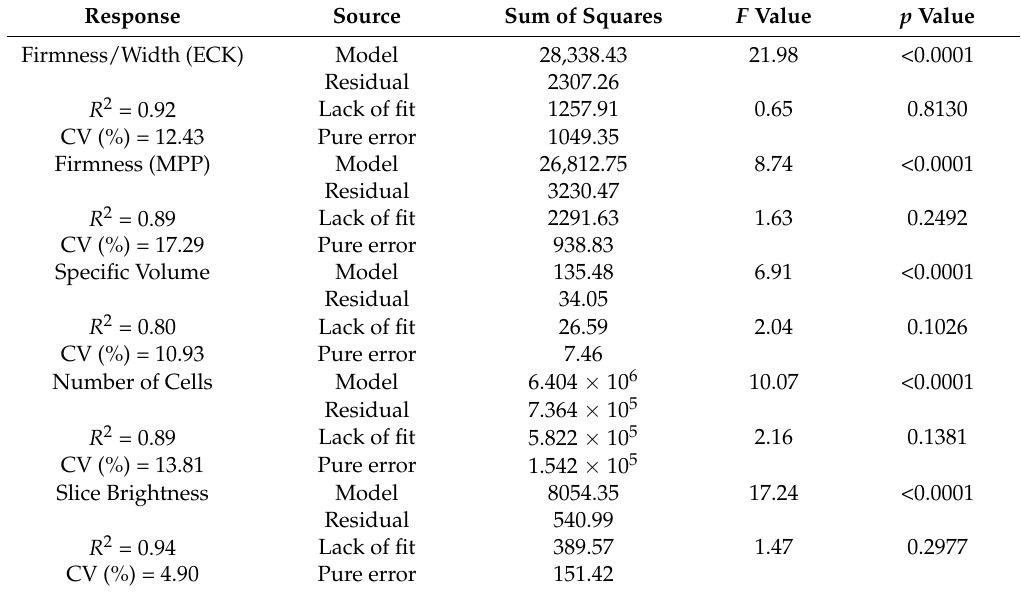
Table 3. Analysis of variance (ANOVA) for evaluation of models for quality parameters of puff pastry. Coefficient of Variation: